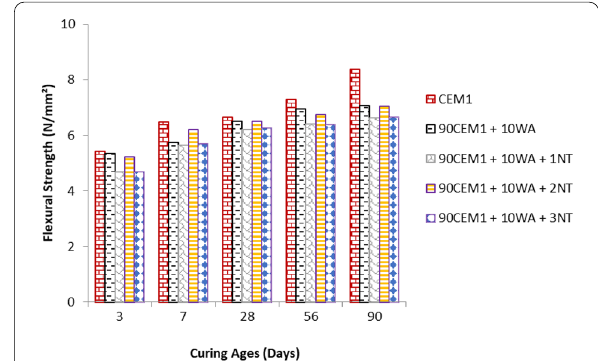
Fig. 4 Influence of NT addition on flexural strength of WA cement mortar.